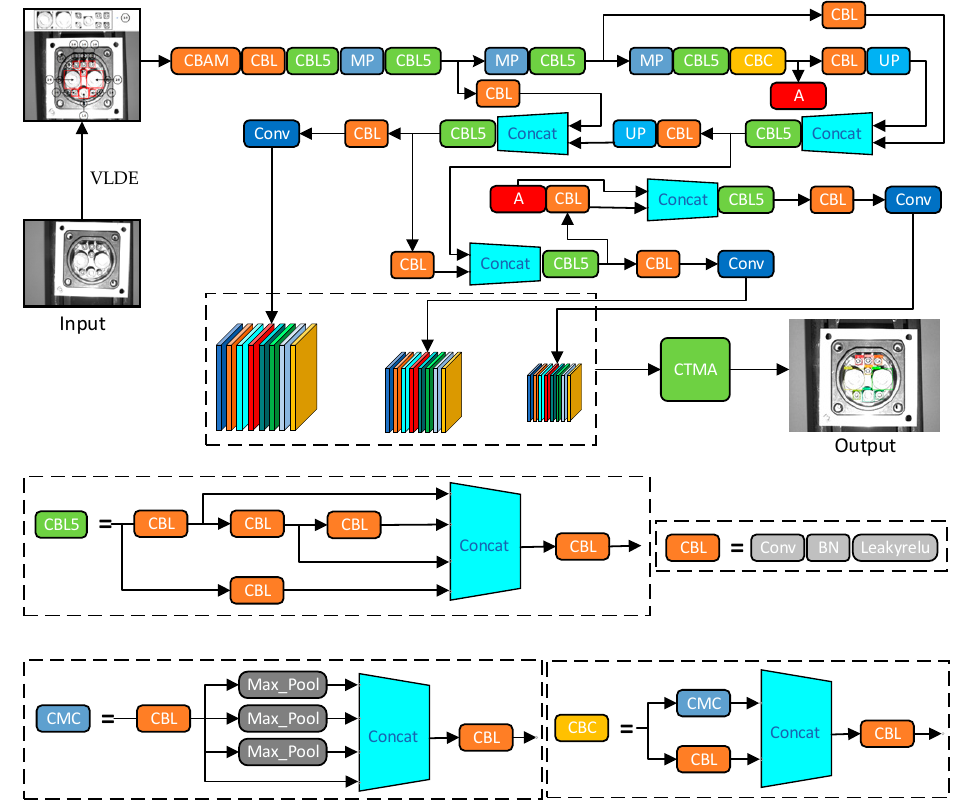
Figure 3. SFLDLC-CBAM-YOLOV7-tinp-CTMA network structure. CONV is the convolution operation, LeakyRelu is the nonlinear activation function, MP is the maximum pooling operation, Up is the upper sampling operation, Concat is the feature fusion function, and Maxpool is the maximum pooling operation. Note: The backbone of YOLOV7-tinp network is divided into four parts: Input, Backone, Neck, and Prediction.